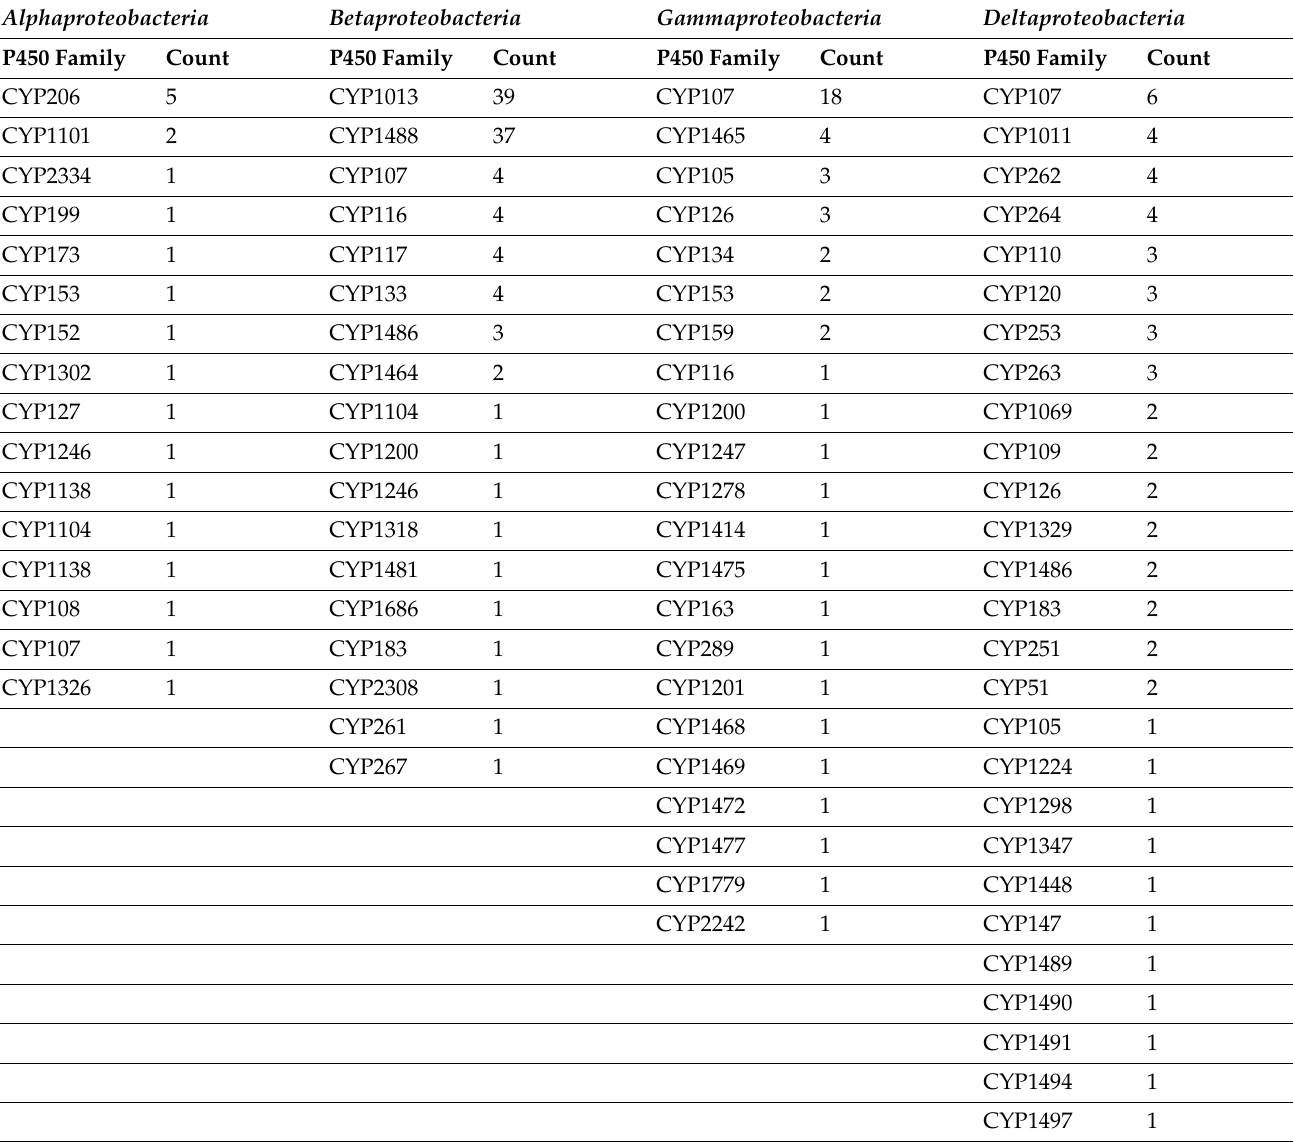
Table 2. Comparative analysis of P450s involved in secondary metabolism in proteobacterial species. P450 family name and number of members that are part of the secondary metabolite biosynthetic gene cluster are shown in the table. Detailed information on secondary metabolite clusters, species, and P450s are presented in Table